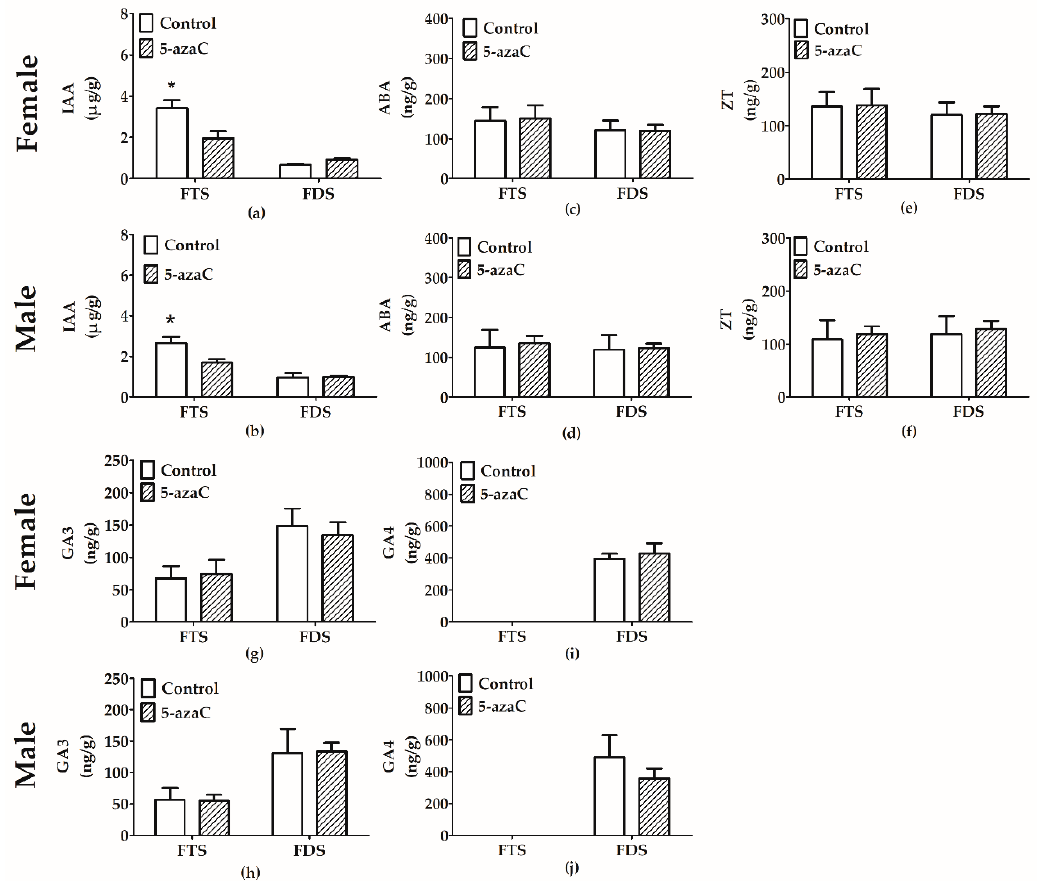
Figure 4. Effects of 5-azaC on the phytohormone contents of male and female Salix viminalis trees. ( a–j ) Contents of indoleacetic acid (IAA; a , b ), abscisic acid (ABA; c , d ), trans-zeatin-riboside (ZT; e , f ), gibberellin 3 (GA3; g , h ) and gibberellin 4 (GA4; i , j ) in female ( a , c , e , g , i ) and male ( b , d , f , h , j ) trees.